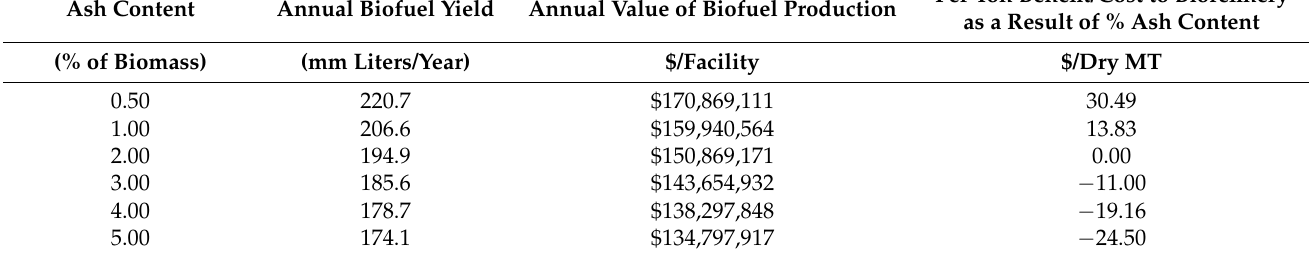
Table 7. Estimates of annual biofuel production and value based on a 2000 metric ton facility when varying ash content in switchgrass feedstock assuming a per liter price of $0.71 and a RIN value of $0.47 per liter. Ash